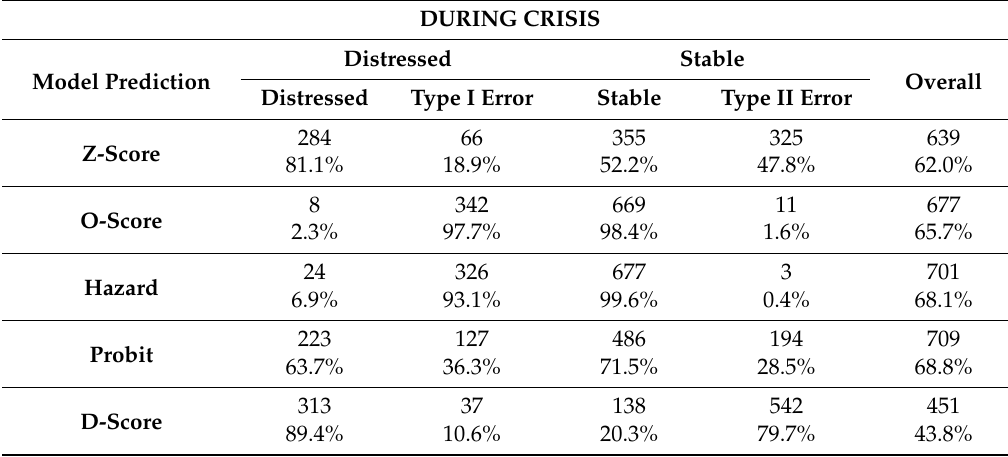
Table 7. Prediction accuracy of models during financial crisis.